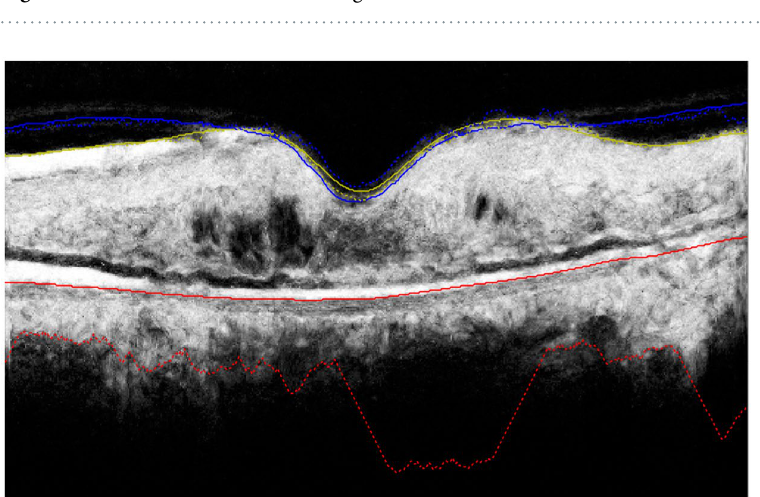
Figure 5. Prediction of the ILM-RPE class. Solid lines: Manual annotation (ground truth); Dashed lines: Base surface